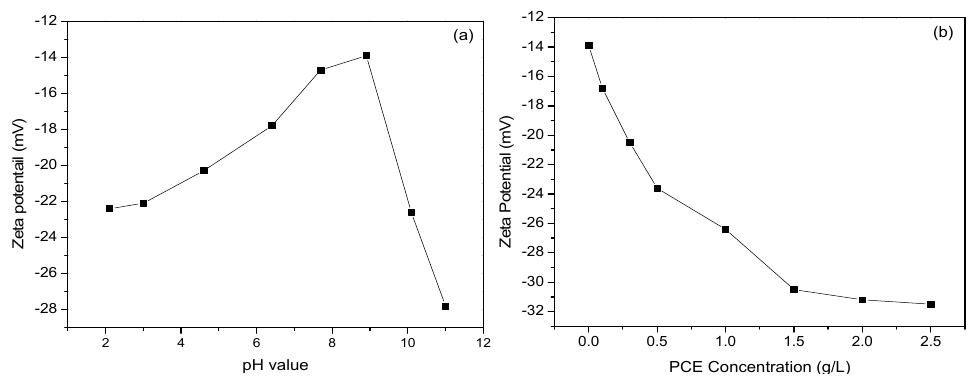
Figure 7. Effect of pH and PCE concentration on the measured zeta potentials of LBSP. ( a ) pH val- ( b ) PCE ues. ( b ) PCE concentration.